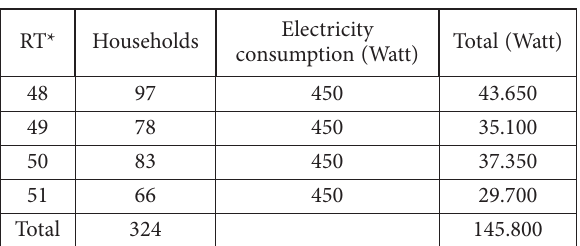
Table 11. The Electricity consumption per day in